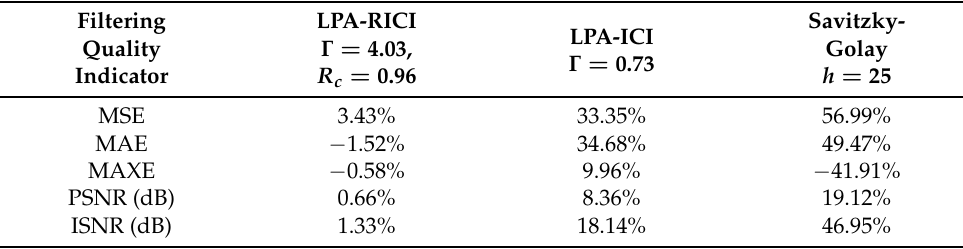
Table 4. Blocks signal (SNR = 5 dB)—Filtering quality improvement of the RBF-RICI-based filtering over other tested